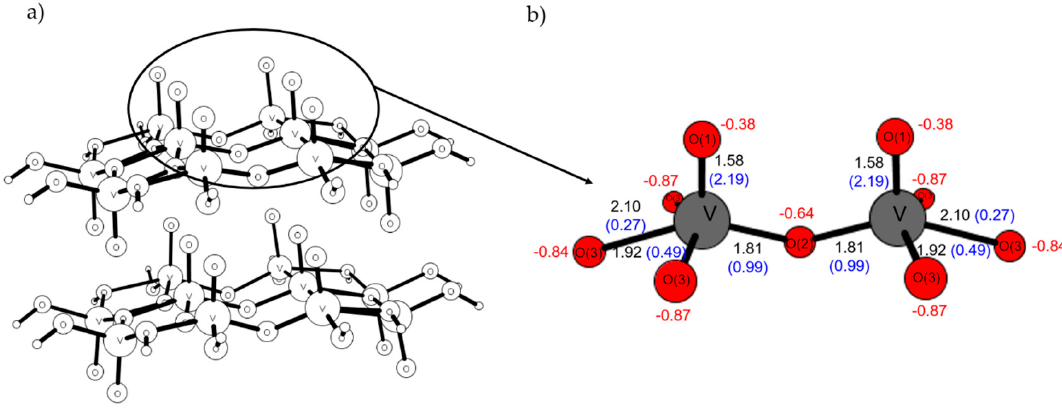
Figure 9. ( a ) V 20 O 62 H 22 cluster representing the (010) V 2 O 5 surface side view; ( b ) parameters characterizing centers present on the model (black—bond lengths in Å; blue, in parentheses—bond order indices; red—Mulliken charges).